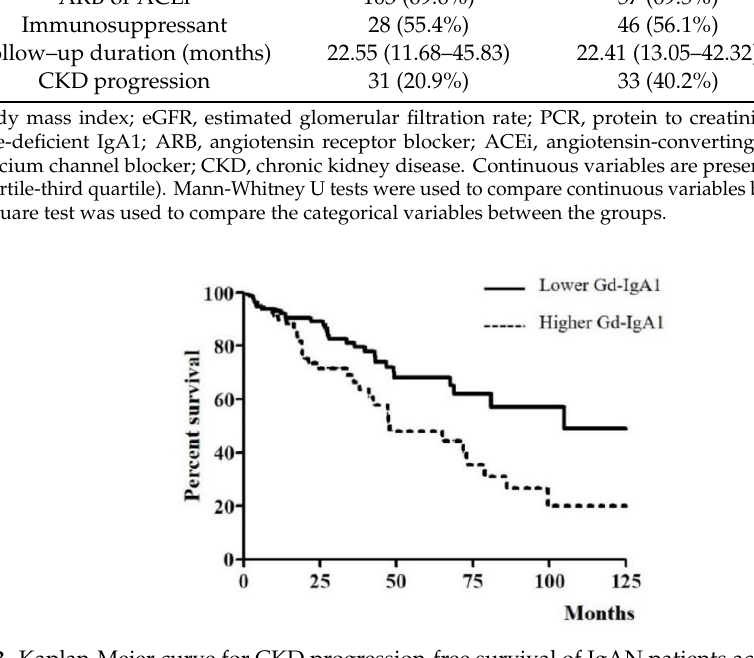
Figure 3. Kaplan-Meier curve for CKD progression-free survival of IgAN patients according to serum Gd-IgA1 levels.